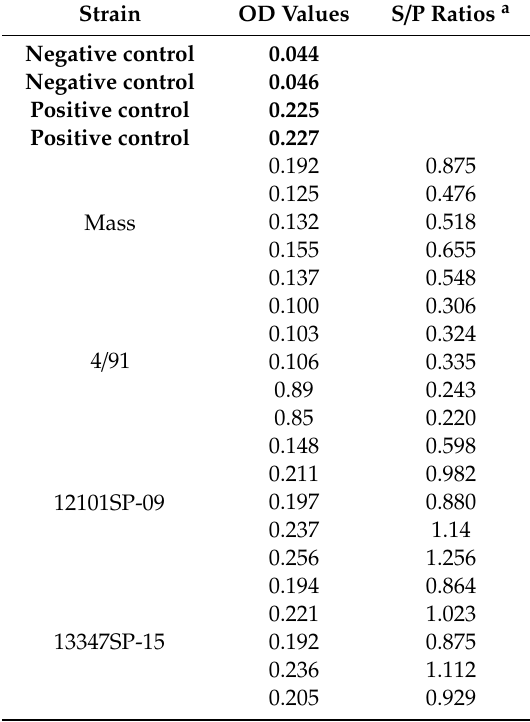
Table 1. Chick antibody levels against di ff erent IBV isolated in di ff erent years, inoculated at 14 and